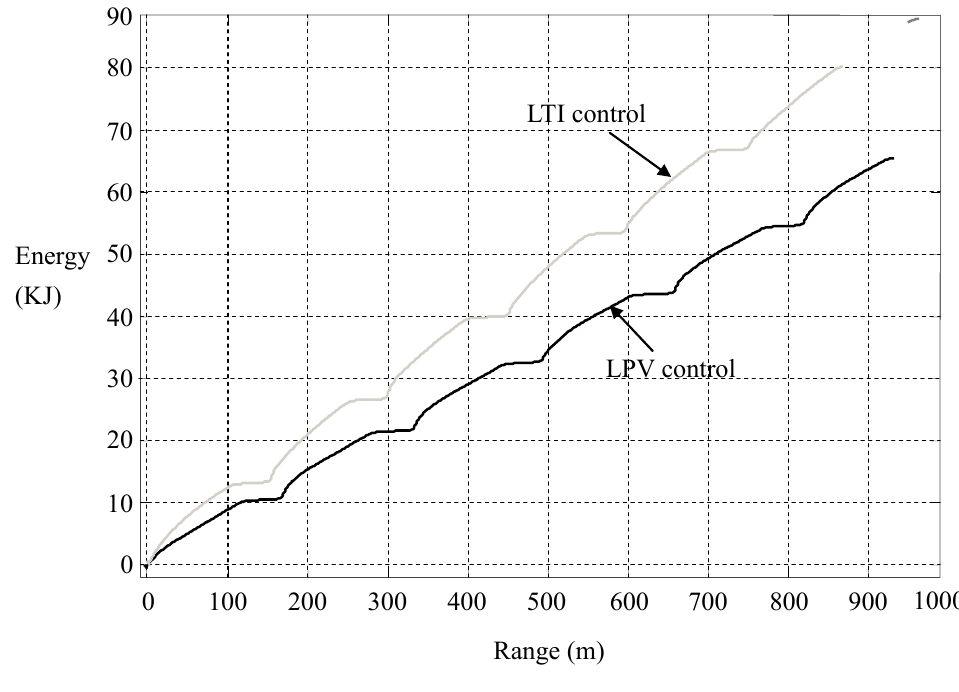
Figure 15. Energy consumptions in LTI and LPV